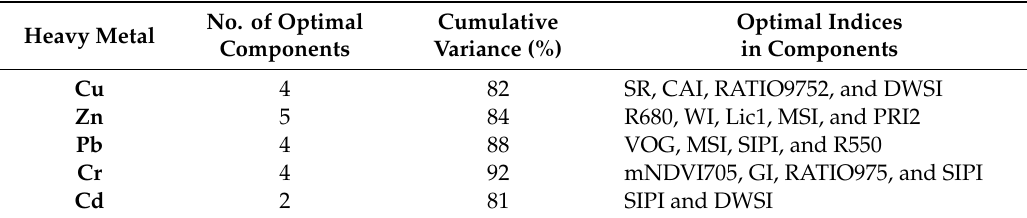
Table 2. Summary of the PLS results on the number of components and optimal indices for estimating heavy metal contents in grapevine leaves.